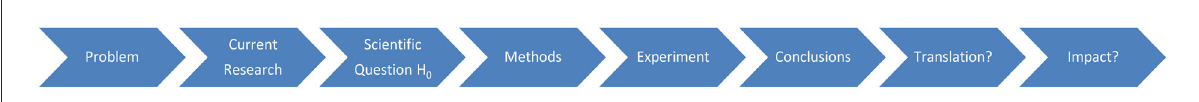
FIGURE3 Traditional science research methodology.